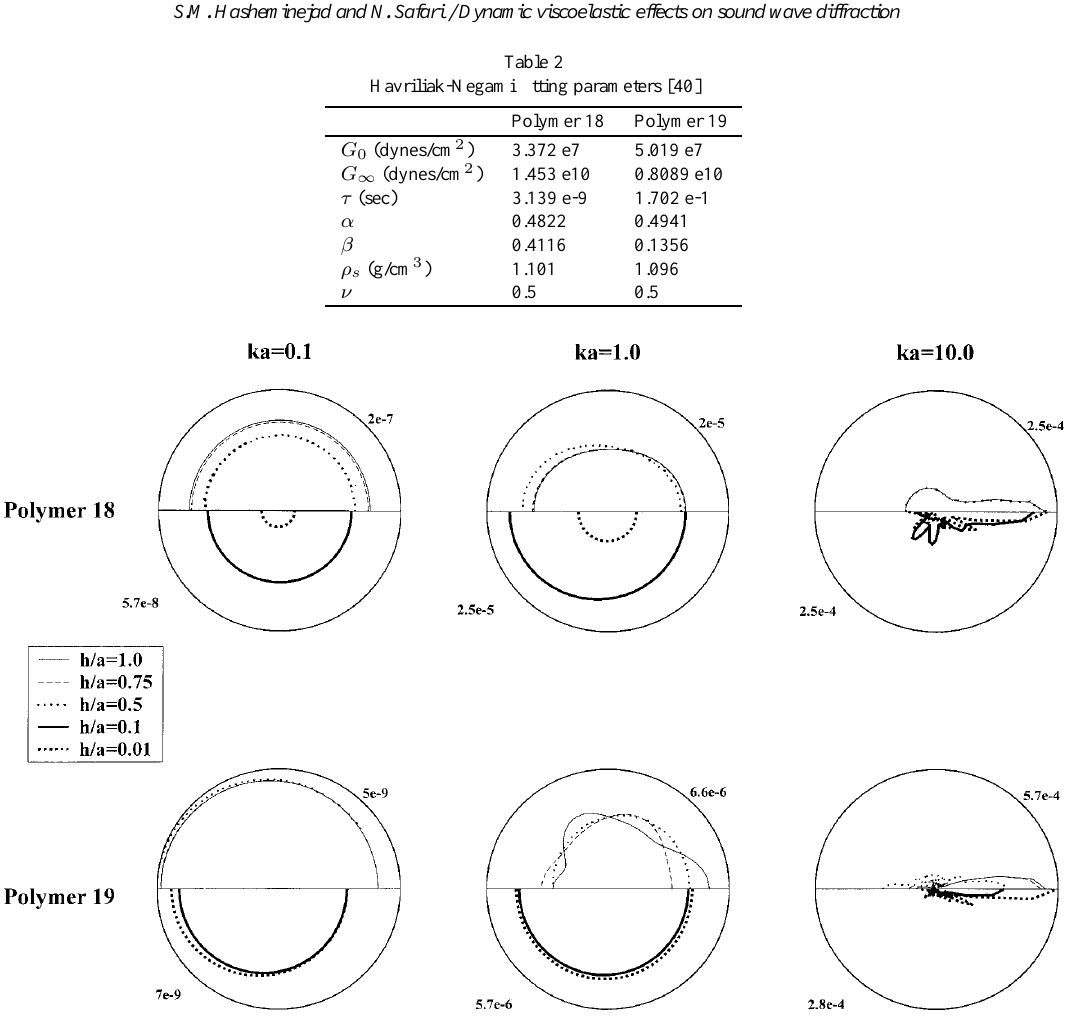
Fig.2. Angular distribution of the scattered far-field pressure for a unit amplitude plane wave incident upon an olive oil-filled spherical viscoelastic shell immersed in glycerine for selected dimensionless wave numbers and shell